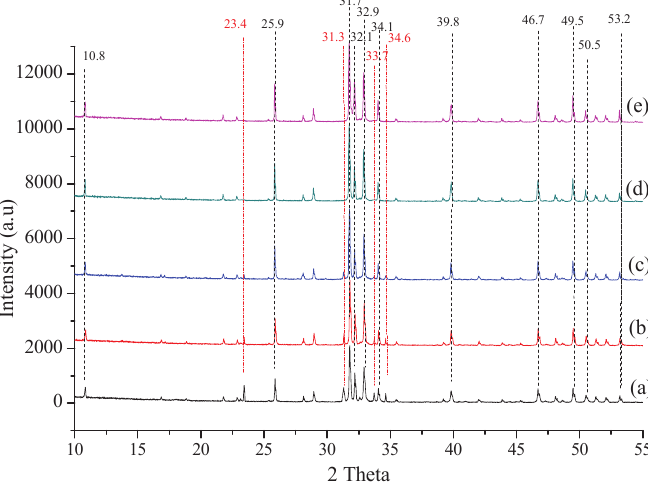
Figure 2: XRD diffraction of HA that was prepared in different concentrations of H (e) Standard HA. Fixed condition: bovine powder/H Table 2: Effect of reaction temperature on size and crystal degree